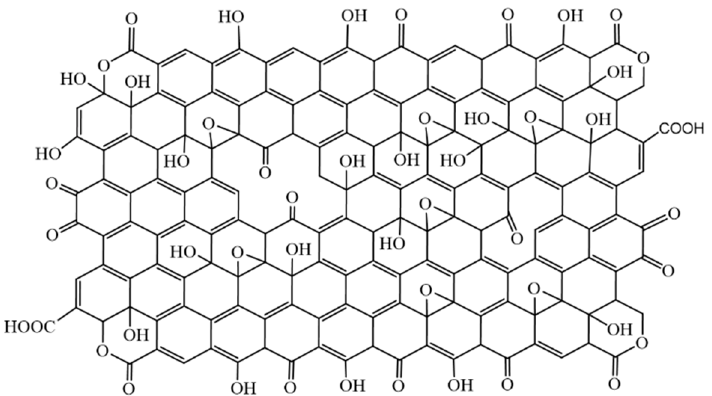
Figure 9. Proposed structure of graphene oxide layer.